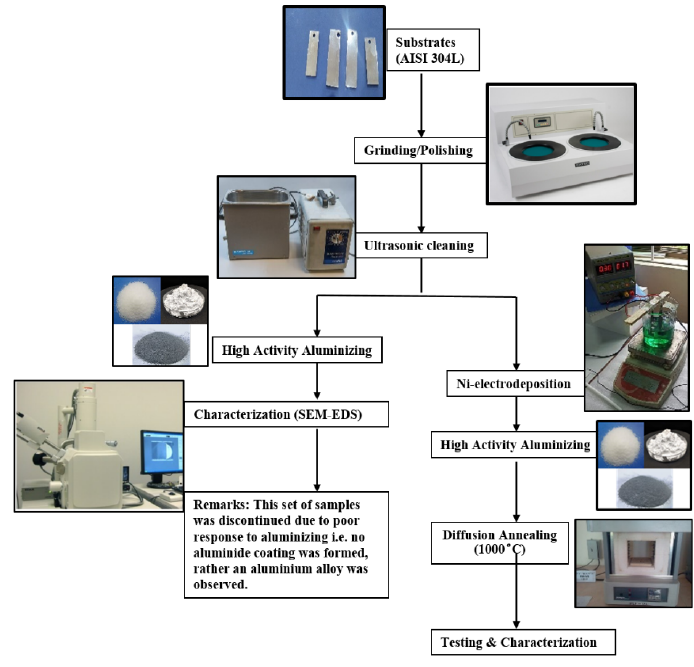
Figure 1. The process flow chart for two sets of